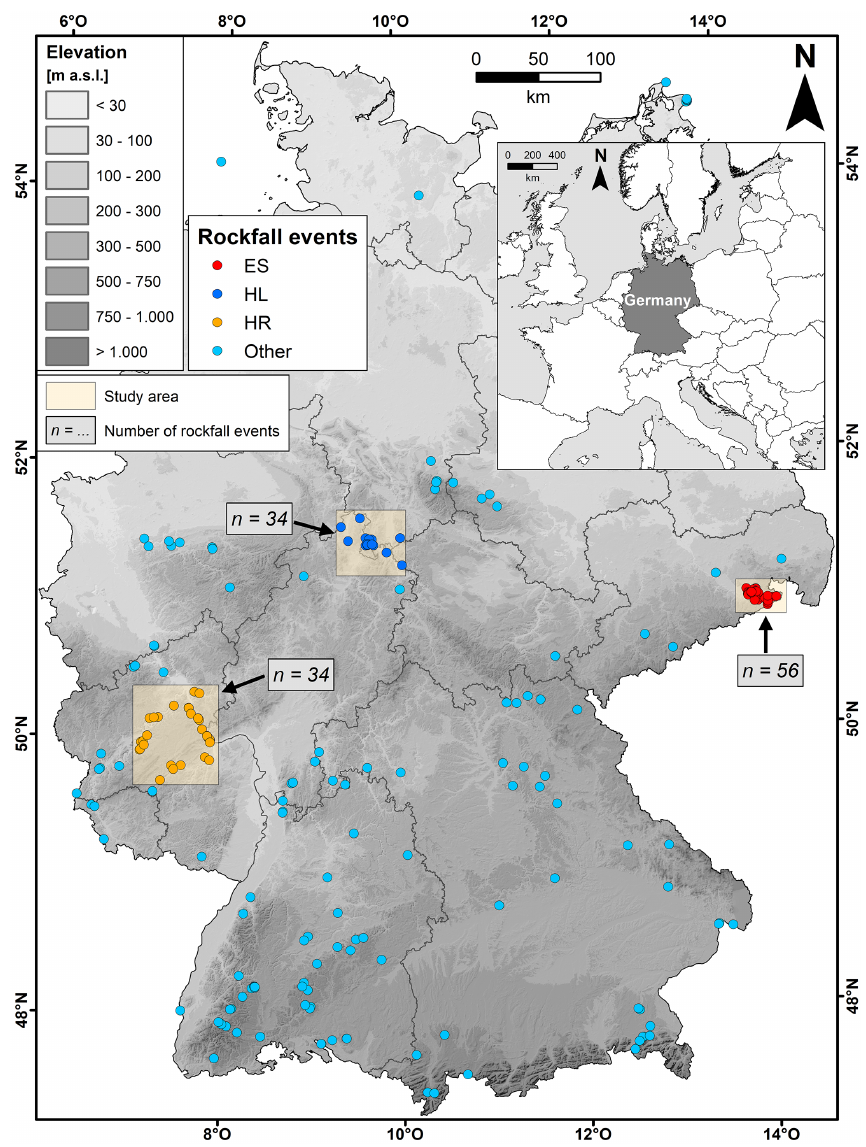
Figure 1. Location of rockfall events analysed in this study. Three distinct clusters – ES (Elbe Sandstone), HL (Hesse and Lower Saxony) and HR (Hesse and Rhineland-Palatinate) – are marked in red, blue and orange, respectively. All other events are coloured in light